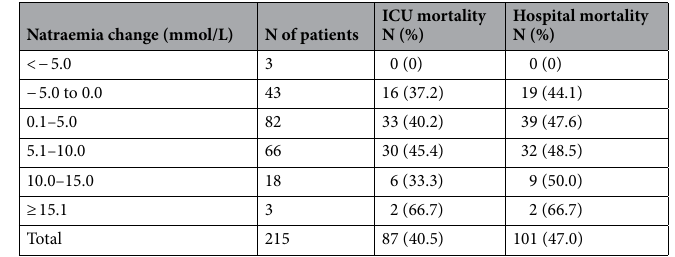
ICU mortality N (%)